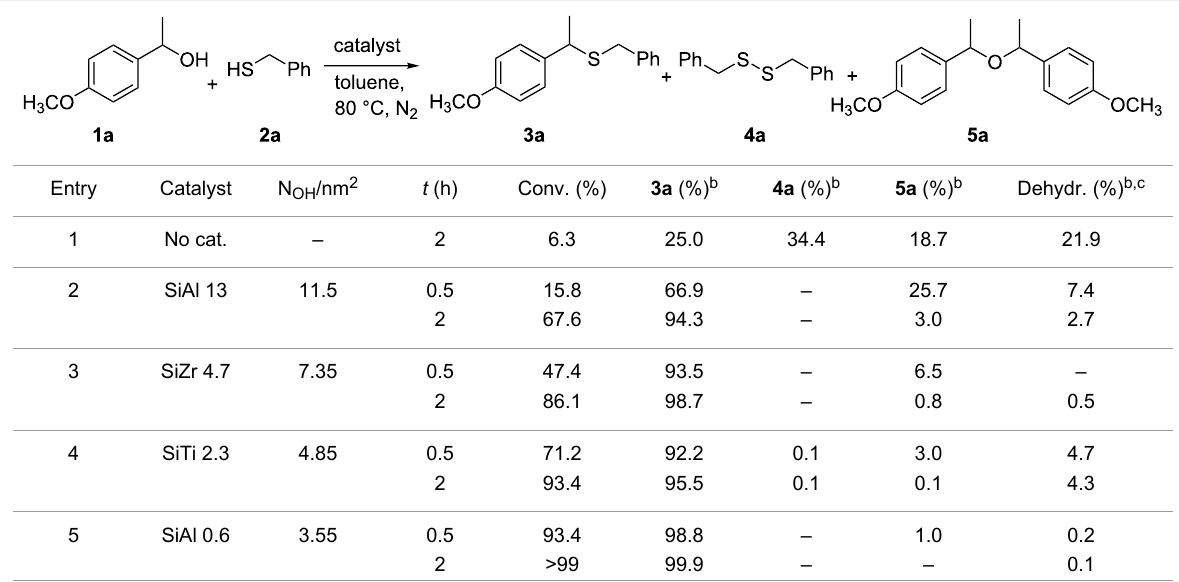
Table 1: Thioethers synthesis in solvent with different catalysts a